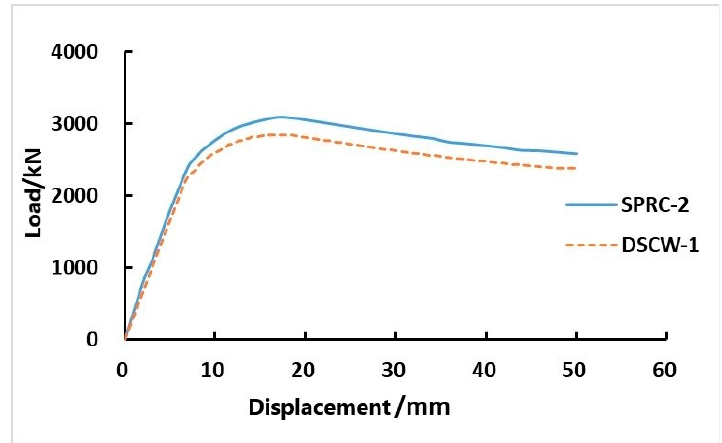
Figure 8. Diagrammatic drawing of simulation assembly 2.